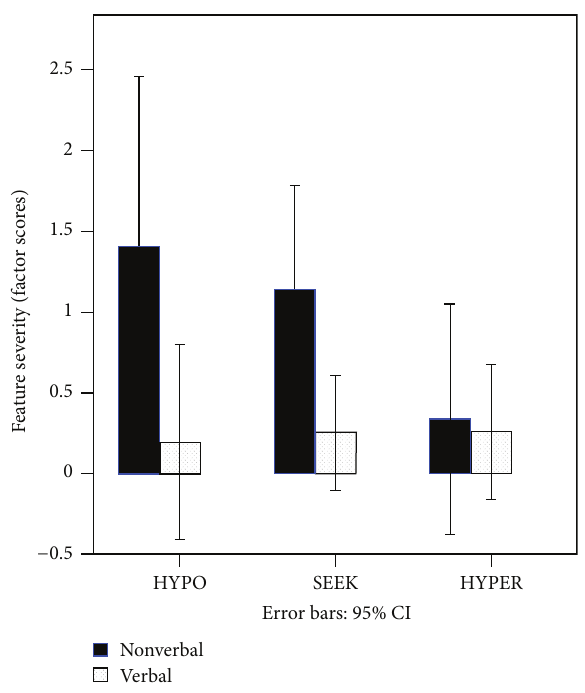
Figure 2: Level of severity of sensory response patterns for verbal and nonverbal subgroups in the longitudinal